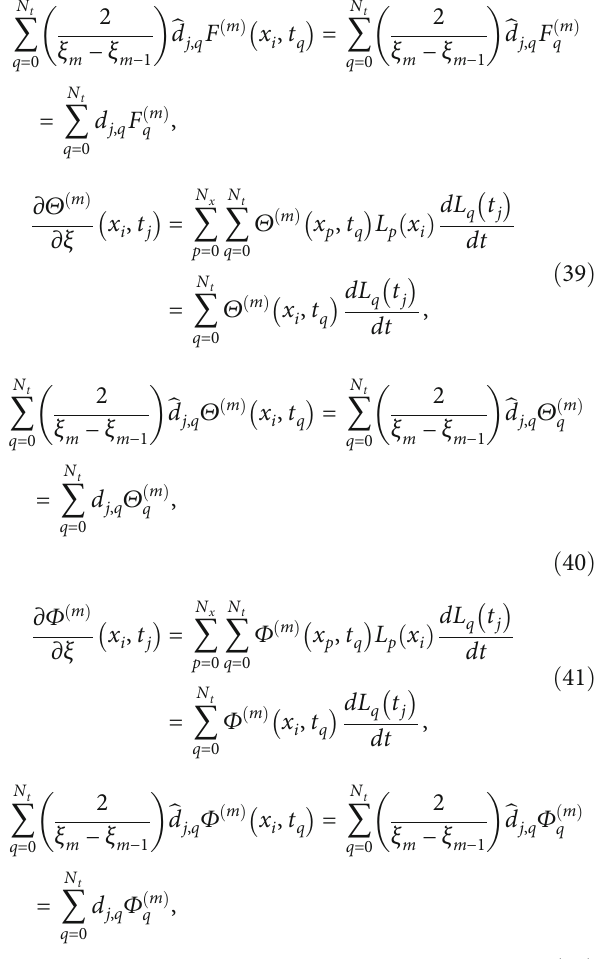
Figure 10: Concentration pro fi le for di ff erent values of N = δ = NR = 0 : 2, Sc = 0 : 6, and Pr = 1